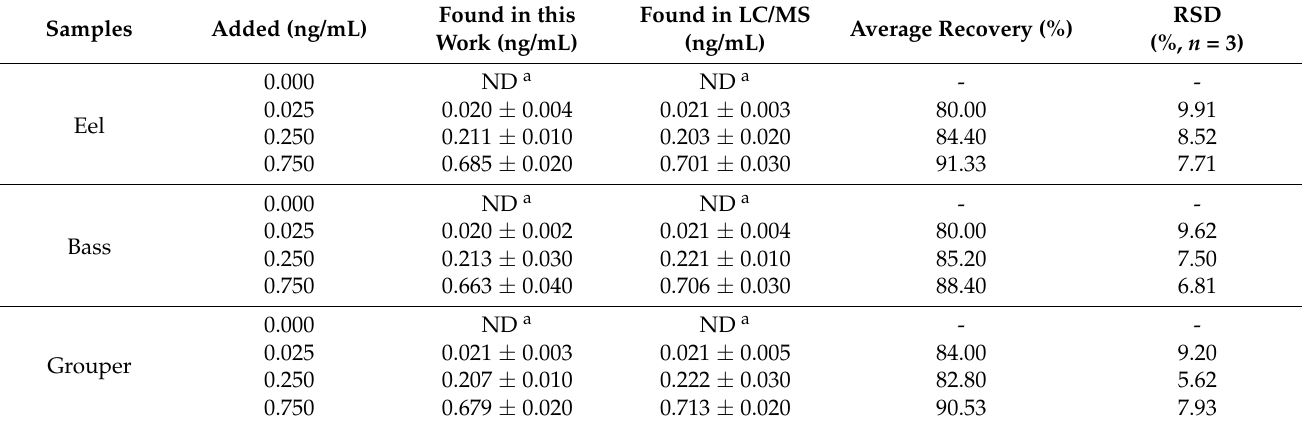
Table 1. MIPs@BCDs/RCDs@SiO 2 and LC/MS determination results for P-CTX-3C in